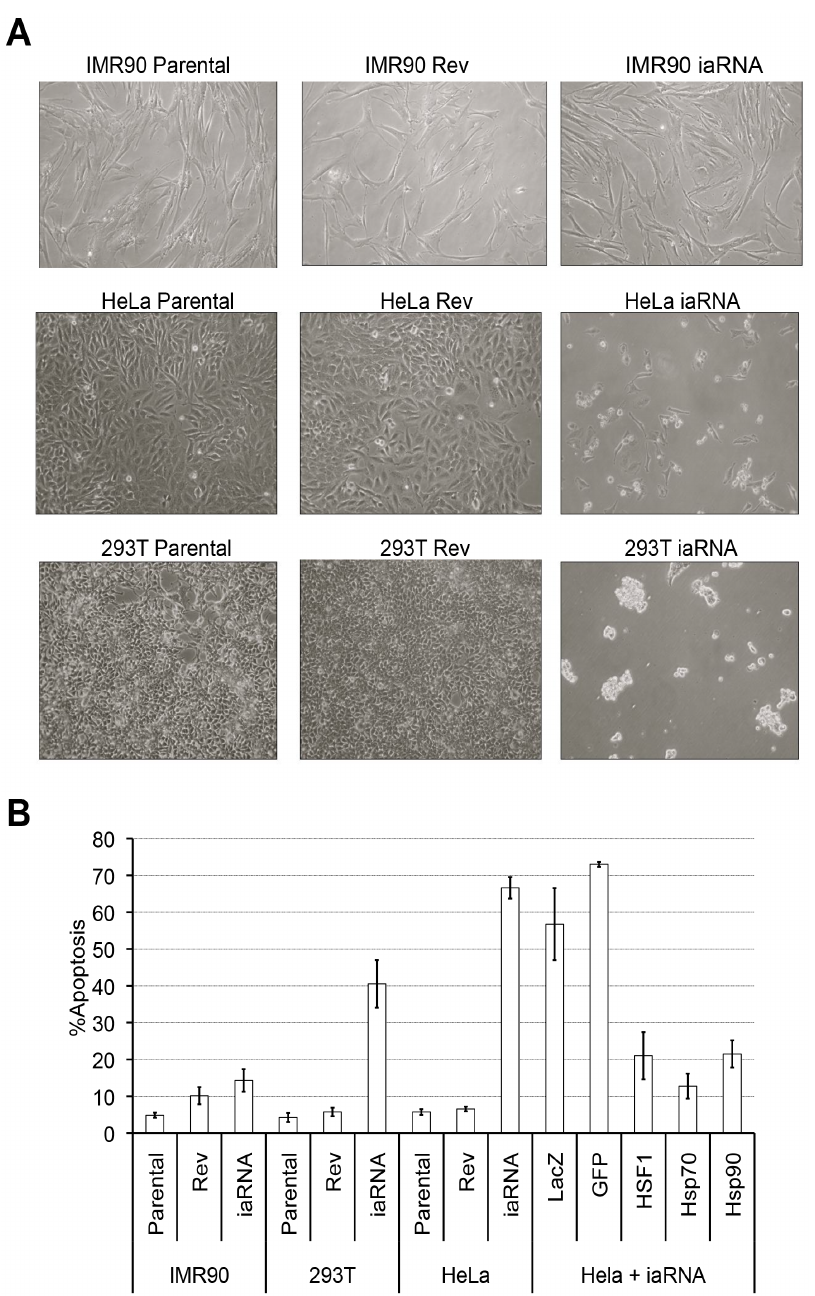
Figure 3. HSF1 inhibition attenuates cancer cell survival. ( A ) iaRNA HSF1 expression does not affect normal cells (IMR90), yet induces an abnormal morphology in HeLa cervical carcinoma and chemically transformed kidney cells (293T). ( B ). Nuclear condensation and fragmentation assays reveal that iaRNA HSF1 expression induces , 10-fold increase in apoptosis in HeLa cells (p , 0.0001) (n=8), and , 7-fold increase in apoptosis in 293T cells (p , 0.0001) (n . 8). Furthermore, iaRNA HSF1 induced apoptosis in effectively suppressed by the over-expression of molecular chaperones (HSF1 p , 0.006, Hsp90 p , 0.005, or Hsp70 p , 0.002), but not random proteins (GFP or LacZ) (n . 8).